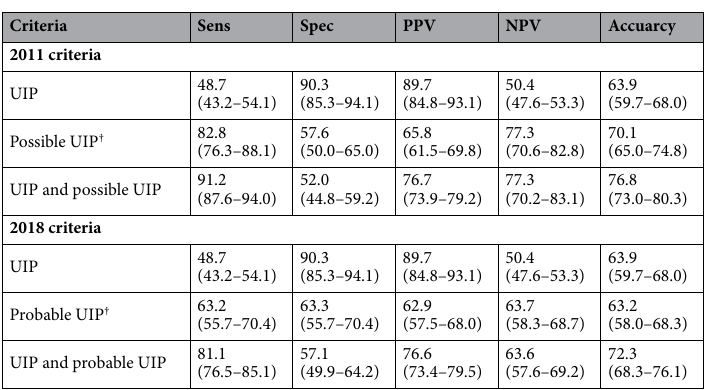
Table 3. Diagnostic performance according to the CT pattern for the diagnosis of idiopathic pulmonary fibrosis. † After excluding patients with CT pattern of UIP. PPV positive predictive value; NPV negative predictive value; AUC area under the receiver-operating characteristic curve; UIP usual interstitial pneumonia.